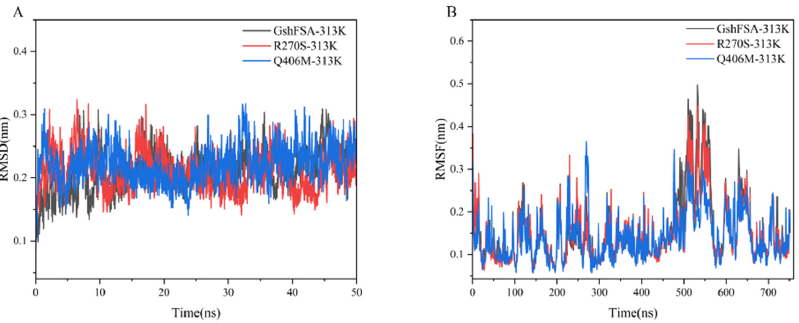
Figure 5. RMSD and RMSF values of WT, R270S and Q406M at 313 K. ( A ) RMSD values of